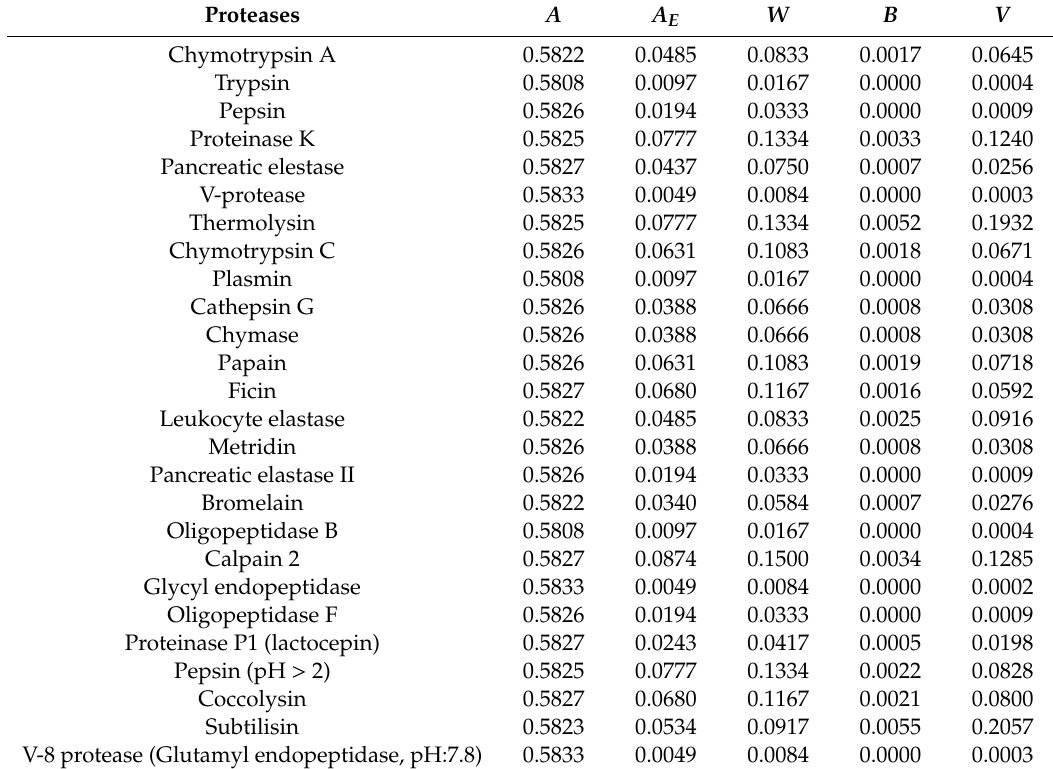
Table 1. The values of the parameters describing the predicted e ffi ciency of bioactive Angiotensin Converting Enzyme (ACE) inhibitor fragment release from Halophila stipulacea- RubisCO by proteases.